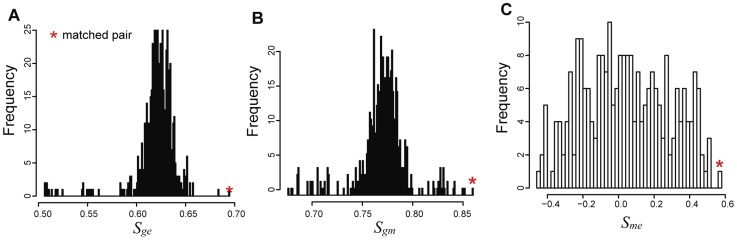
Distribution of similarity scores.(A) The distribution of similarity scores of one profile versus all profiles of other omics data type based on cis-eQTLs. (B) The distribution of similarity scores of one profile versus all profiles of other data type based on cis-mQTLs. (C) The distribution of similarity scores of one profile versus all profiles of other data type based on cis mRNA-methylation pairs. If two profiles pertain to the same sample (self-consistent), their similarity scores (red stars) are expected to be higher than those of cross-matched pairs.